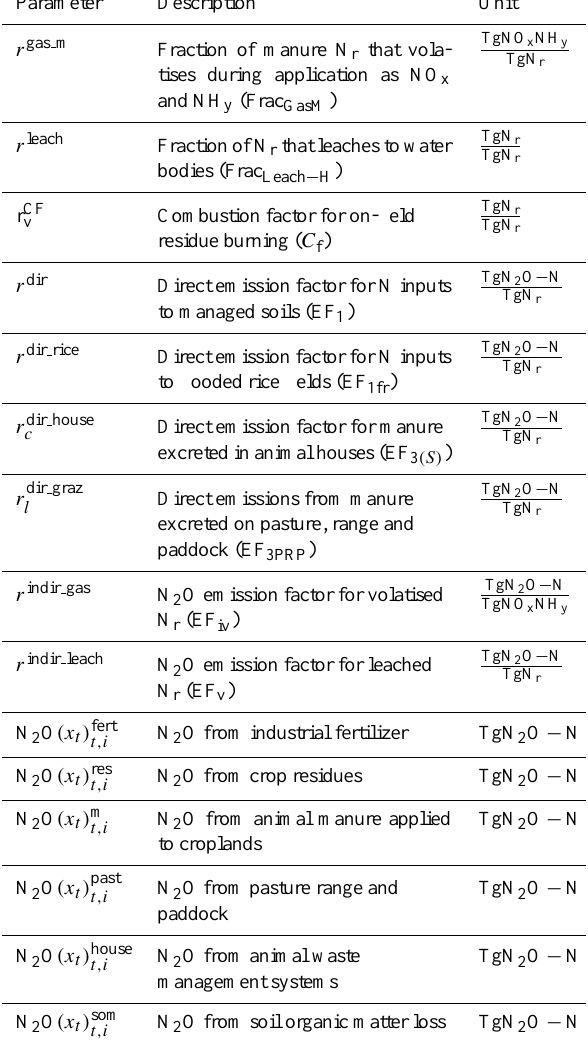
Table A3. Estimates of crop growth functions: AG residues inter-